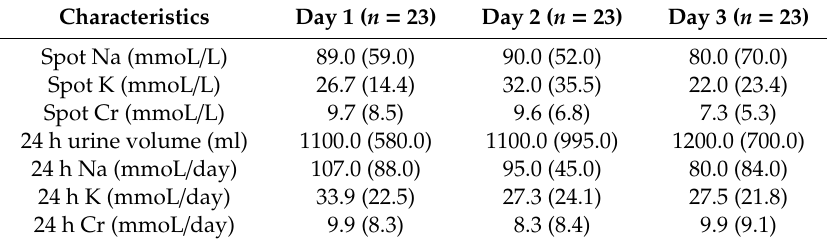
Table 2. Spot and 24 h urinary Na, K, and Cr, by collection